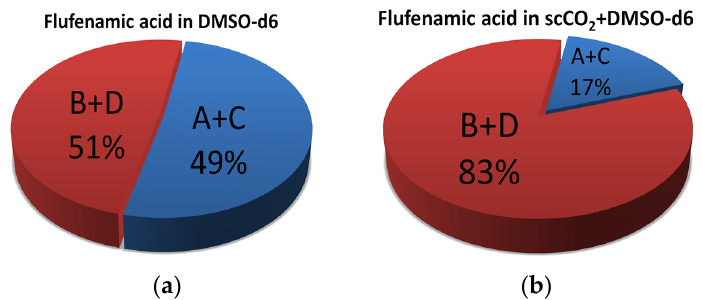
Figure 8. Distribution of conformers of FFA in DMSO ( a ) and SC-CO 2 +DMSO ( b ) calculated from the observed conformation-dependent distance NH-H7.